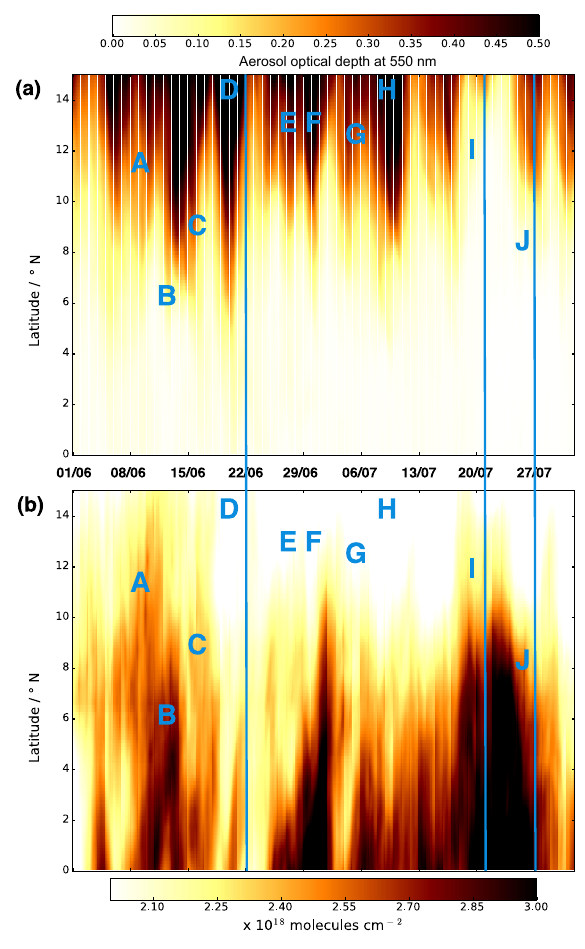
Figure 18. Occurrence of mineral dust (a) and CO (b) plumes over the DACCIWA region. Hovmöller plots for the longitude range 8 ◦ W–8 ◦ E covering the whole June–July 2016 period generated from CAMS-IFS forecast data. Mineral dust plumes are indicated by DAOD at 550nm and show the transport of dust from north of the domain (i.e. Sahel and Sahara). The CO is column integrated and primarily shows the transport of air from the SH influenced by biomass burning. The four phases of the DACCIWA campaign are indicated with blue lines. The most significant synoptic features A– J are marked at the approximate time and latitude of crossing the DACCIWA focus